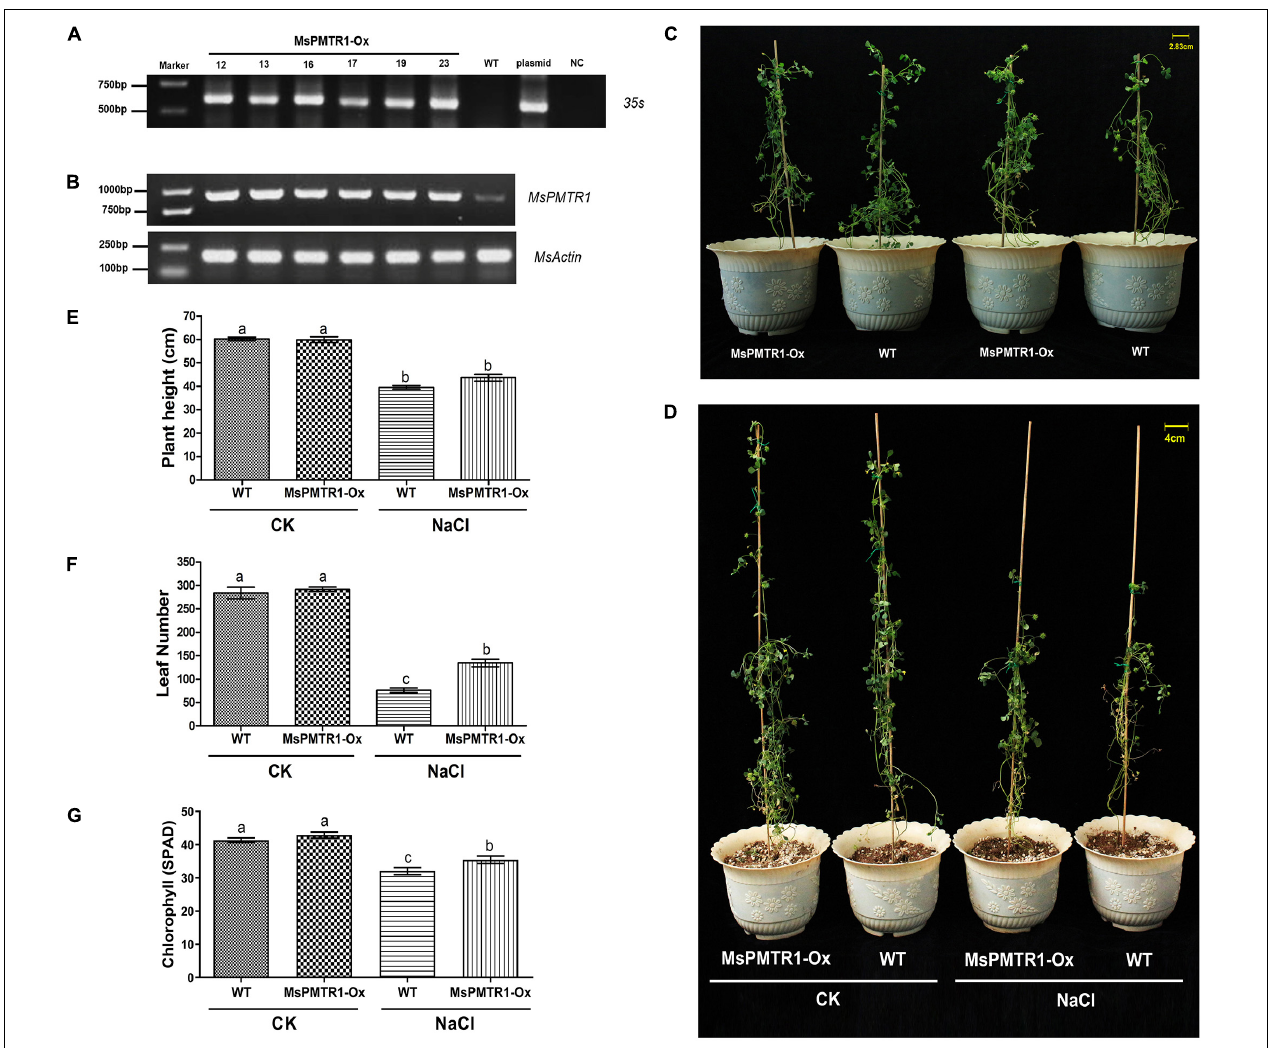
FIGURE 8 | Hairy root overexpression of MsPMTR1 in M . sativa and phenotypic analysis of transgenic lines under salt stress. (A) PCR detection of transgenic alfalfa lines. MsPMTR1 -Ox, MsPMTR1 overexpressed plants, and different lines are indicated. WT, wild-type plant. Plasmid, pCambia1307- MsPMTR1 plasmid as a positive control for PCR. NC, negative control for PCR. The sizes of DM2000 markers are shown on the left. (B) RT-PCR confirmation of MsPMTR1 expression. MsActin expression is detected as endogenous control. (C) The phenotype of a representative individual from transgenic and wild-type plants before treatment. (D) The phenotype of a representative individual from transgenic and wild-type plants after 21 days of treatment. CK, control water treatment. NaCl, 137 mM NaCl treatment. (E–G) plant height, leaf number, and chlorophyll content after 21 days of control and NaCl treatment on both transgenic and wild-type plants. Three biological replicates were performed for each assay. Error bars show the SE between biological replicates and a t -test was performed between different treatment groups. Different numbers indicate significant differences ( p (cid:53) 0.05) between different